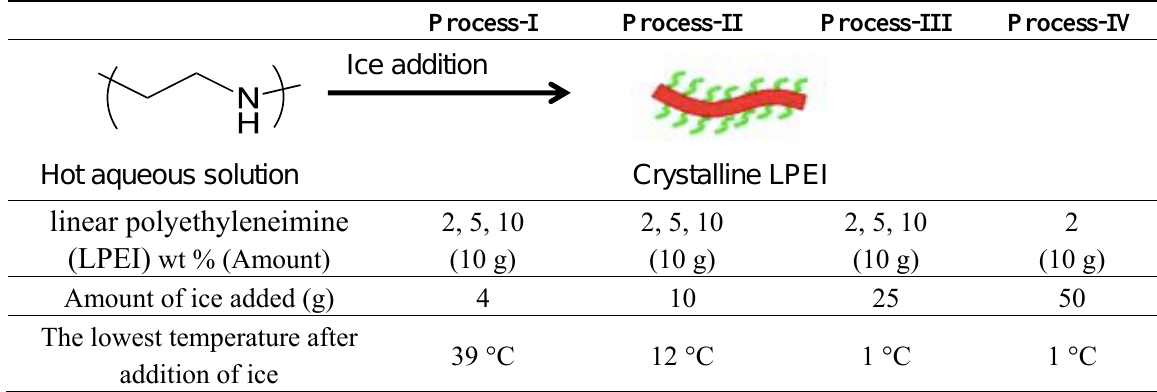
Table 1. Temperature changes after addition of crushed